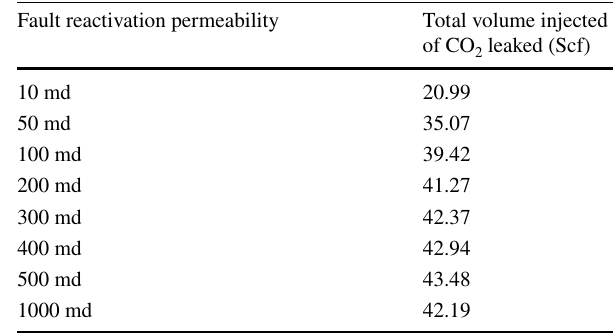
Table 9 Values of fault reactivation time at the topmost fault block, Table 10 Quantities of injected carbon dioxide leaked at which corresponds to the injection well shut-in dates Varying hydraulic fracture permeability models Time of reactiva- tion = shut-in